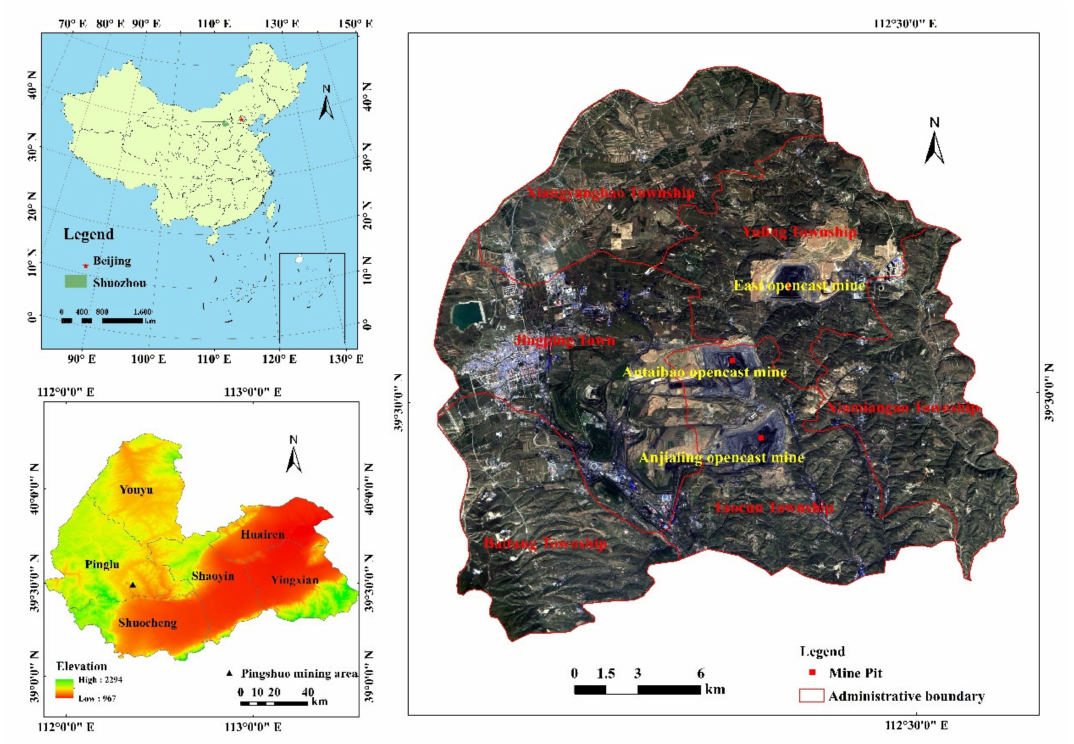
Figure 1. Schematic diagram of the geographical location of the study